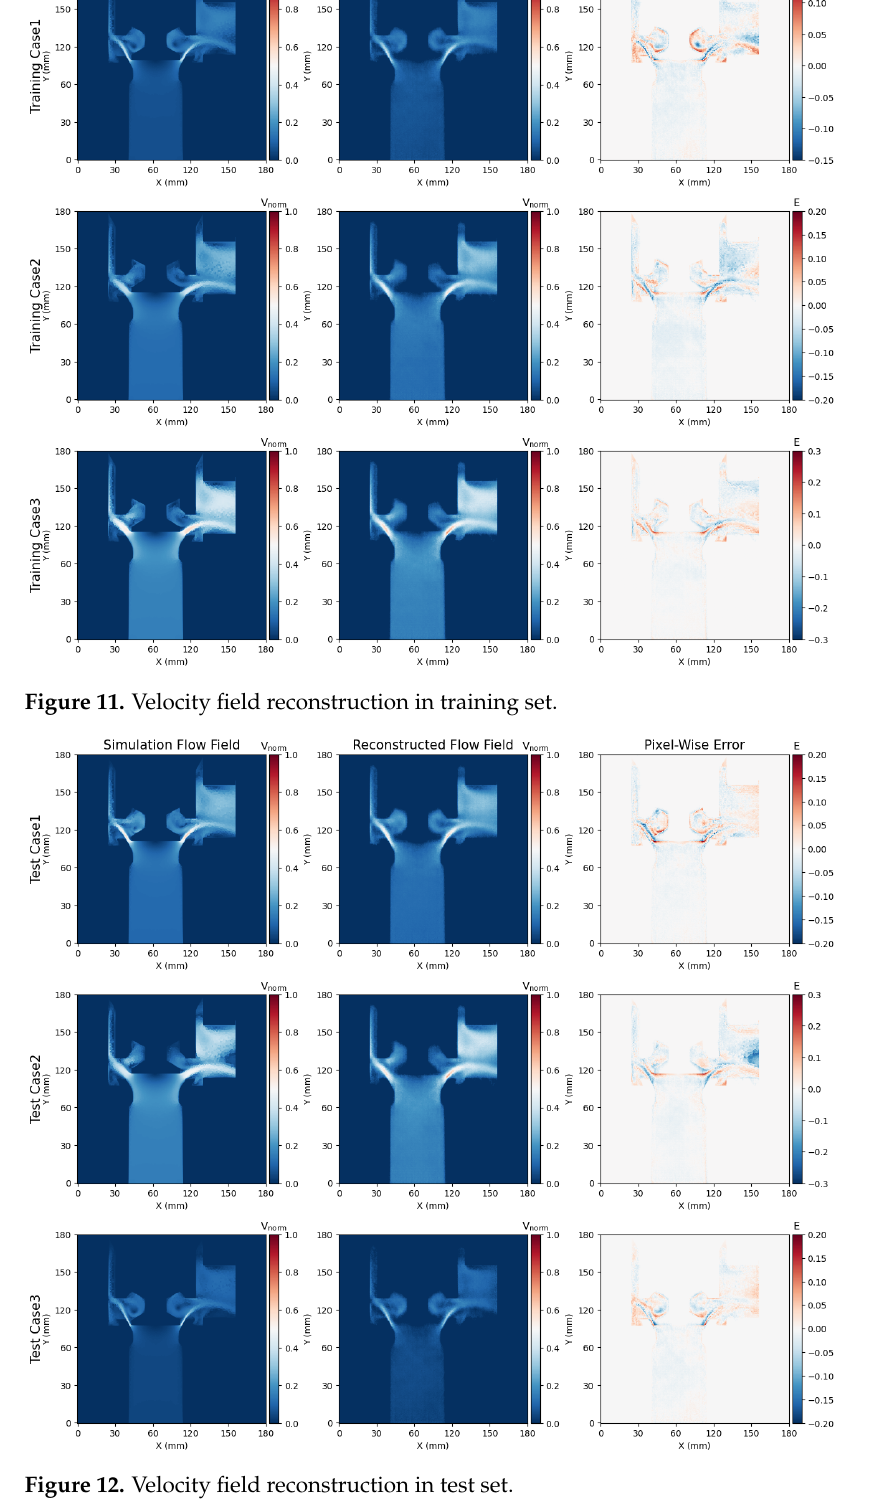
Figure 12. Velocity field reconstruction in test